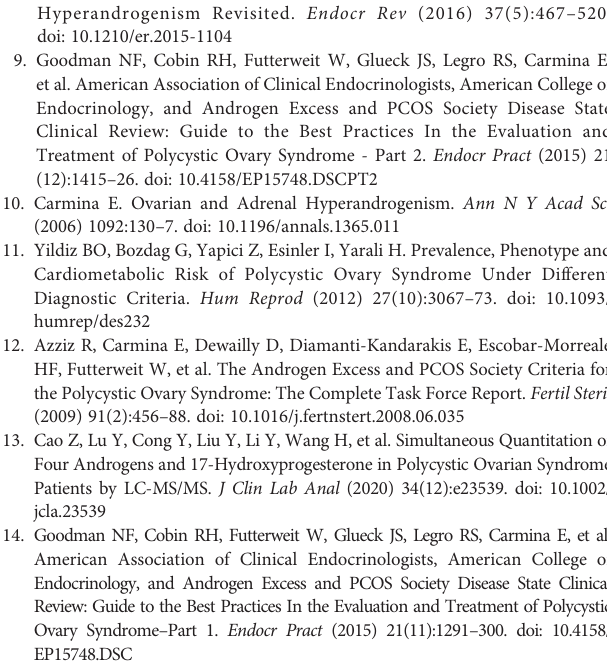
Supplementary Figure 1 | Box plots representing the serum levels of testosterone (T), free testosterone (FT), bioavailable testosterone (Bio-T), androstenedione (A2), dihydrotestosterone (DHT), dehydroepiandrosterone (DHEA), dehydroepiandrosterone sulfate (DHEAS), anti-mullerian hormone (AMH) and the ratio of luteinizing hormone (LH)/follicle stimulating hormone (FSH) in the PCOS and non-PCOS groups. Asterisk (*) indicates p<0.05. Supplementary Figure 2 | Pearson ’ s correlations between serum AMH level or LH/FSH ratio and androgens (T, FT, Bio-T, A2, DHT and DHEAS) in both of the PCOS and non-PCOS